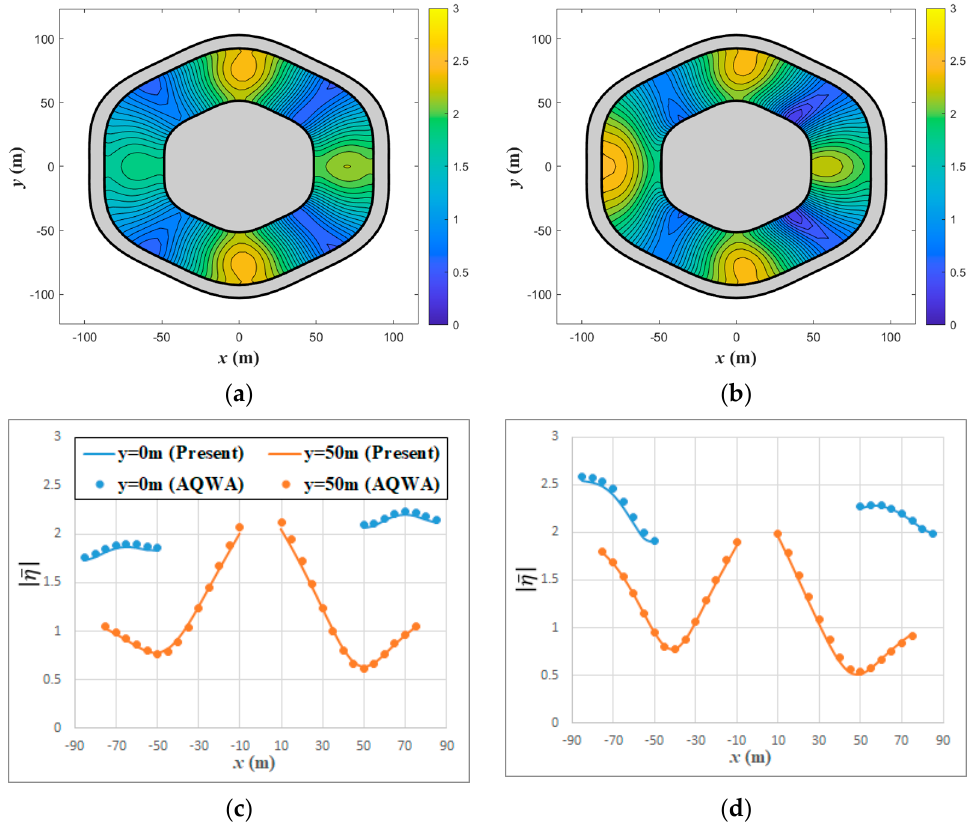
Figure 6. Comparison of normalised wave elevations and profiles for together or individually oscillating floating hexagonal platform and ring structure obtained from AQWA and present approach (for T = 10 s): ( a ) wave field for monolithic motion; ( b ) wave field for individual motion; ( c ) wave profile for monolithic motion; ( d ) wave profile for individual motion.